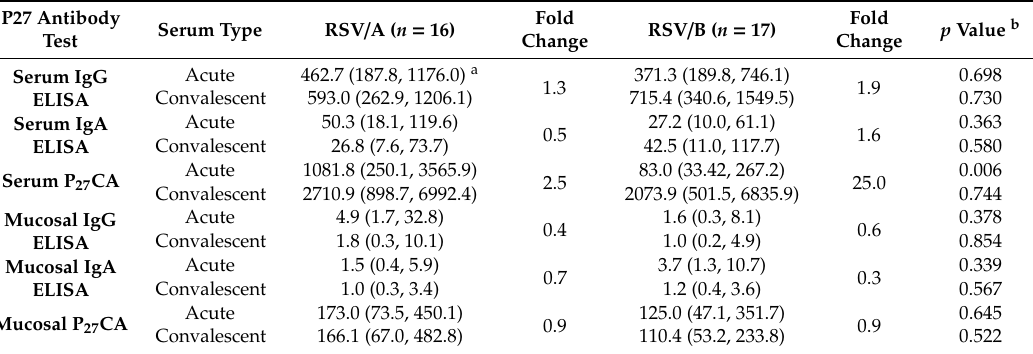
Table 4. P27 antibody concentrations between RSV / A versus RSV / B infected HCT adults. P27 Antibody